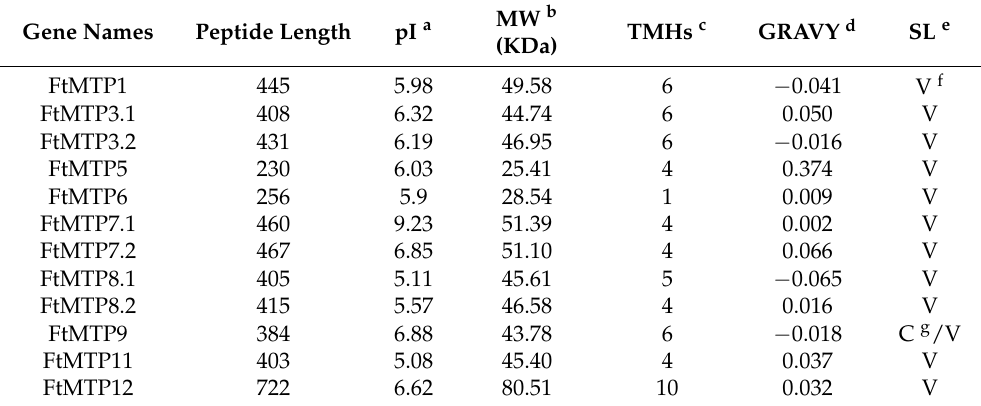
Table 1. Sequences and characteristic analysis of the FtMTP